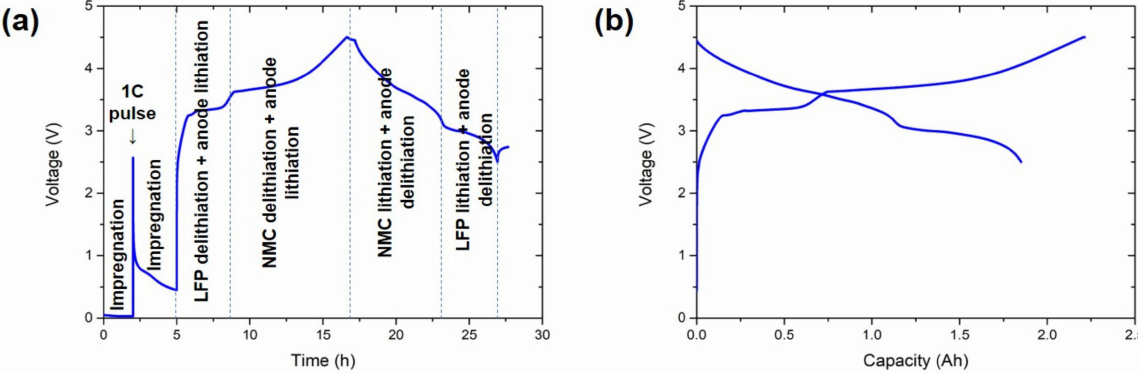
Figure 1. Characteristic conditioning cycle of the cells. ( a ) Voltage vs. time representation and ( b ) voltage vs. capacity representation. Electrochemical processes at each step of the profile are indicated in ( a